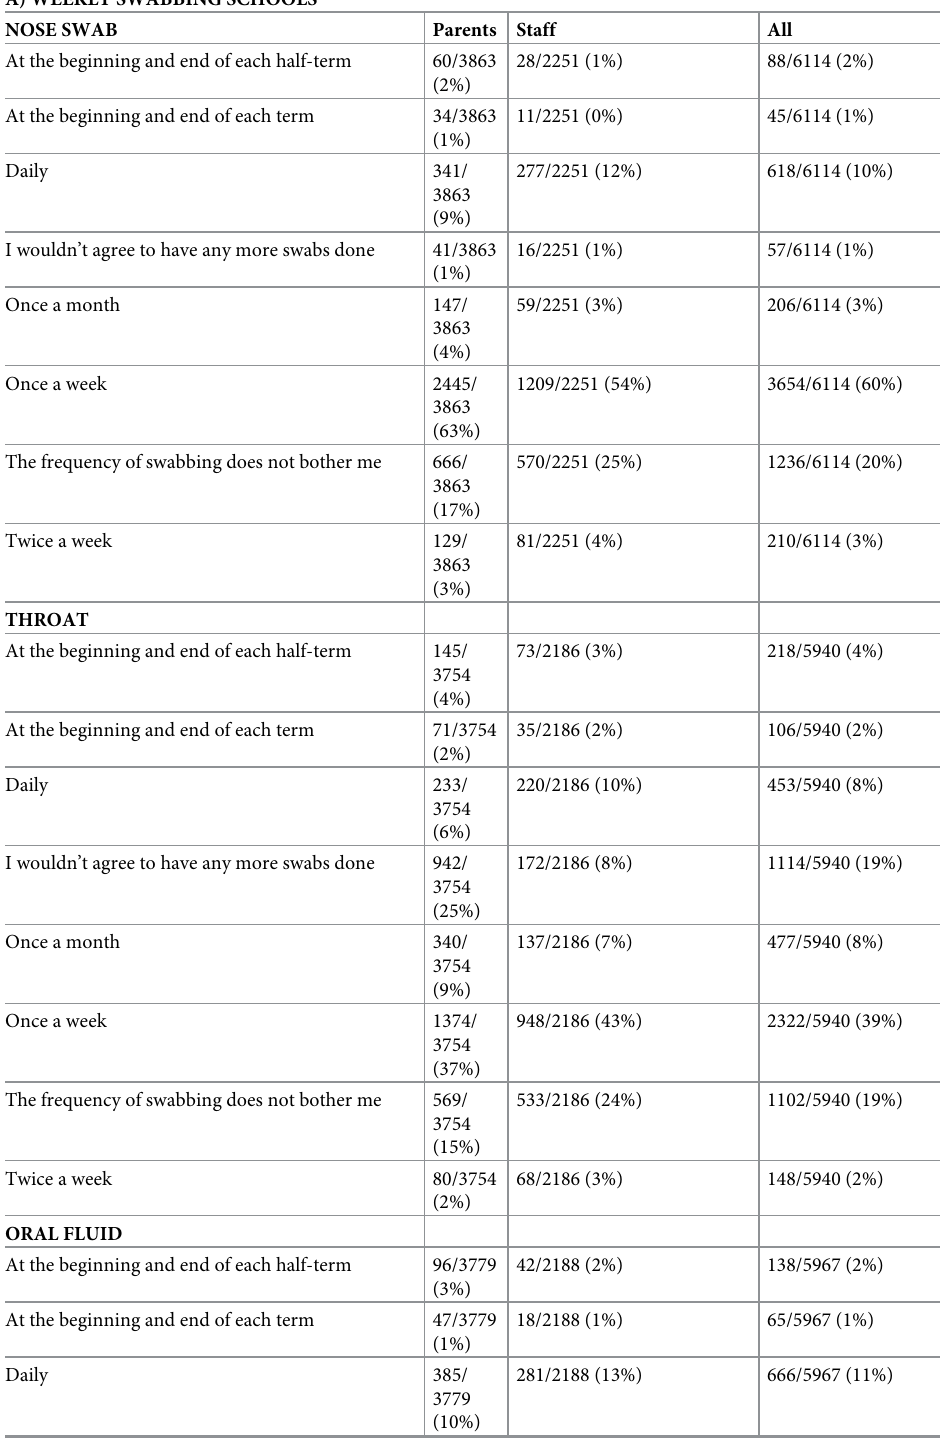
Table 3. Responses of Staff and Parents of children in primary schools in relation to frequency of testing for each investigation in schools participating in (A) weekly swabbing and (B) blood